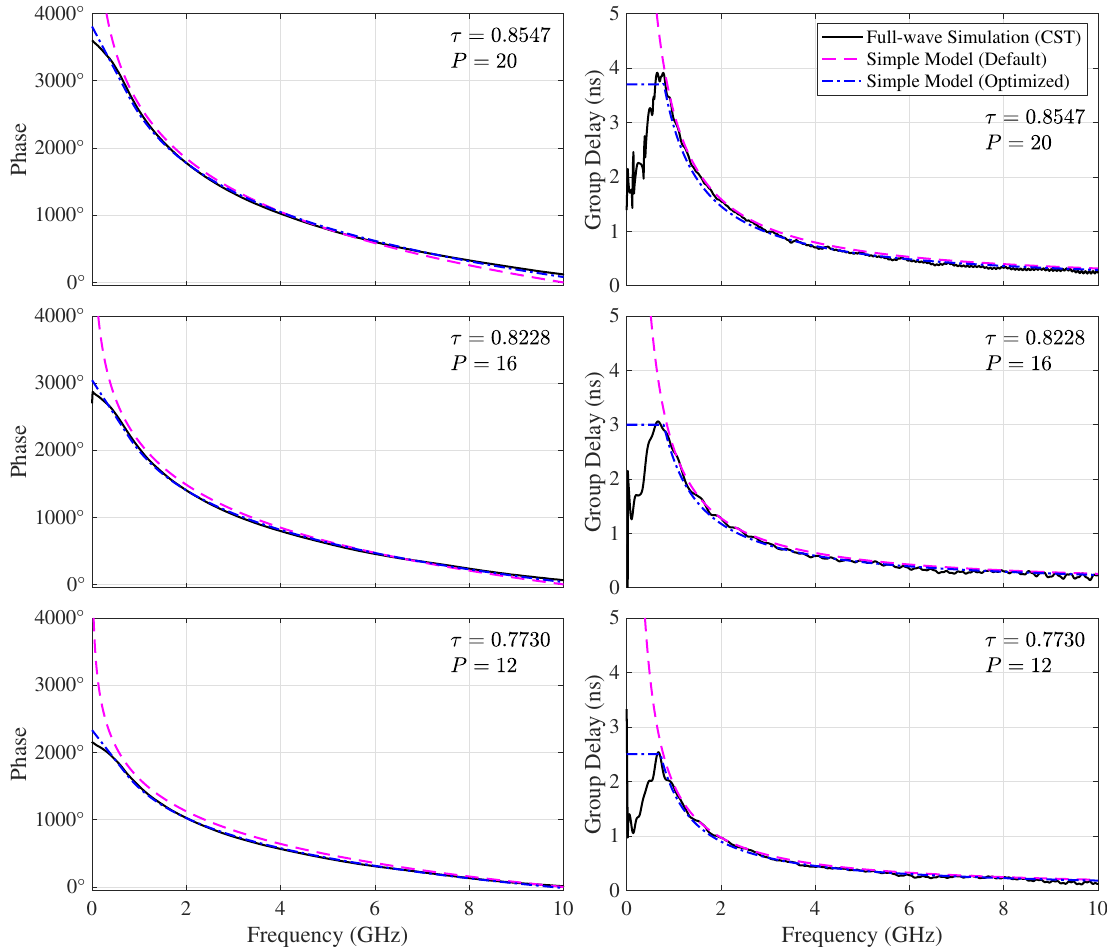
Figure 6. Full-wave simulation vs. simple model of both phase ( left ) and group delay ( right ) due to dispersion in the 20, 16, and 12 cell sinuous antennas. Note that phase unwrapping starts at 10